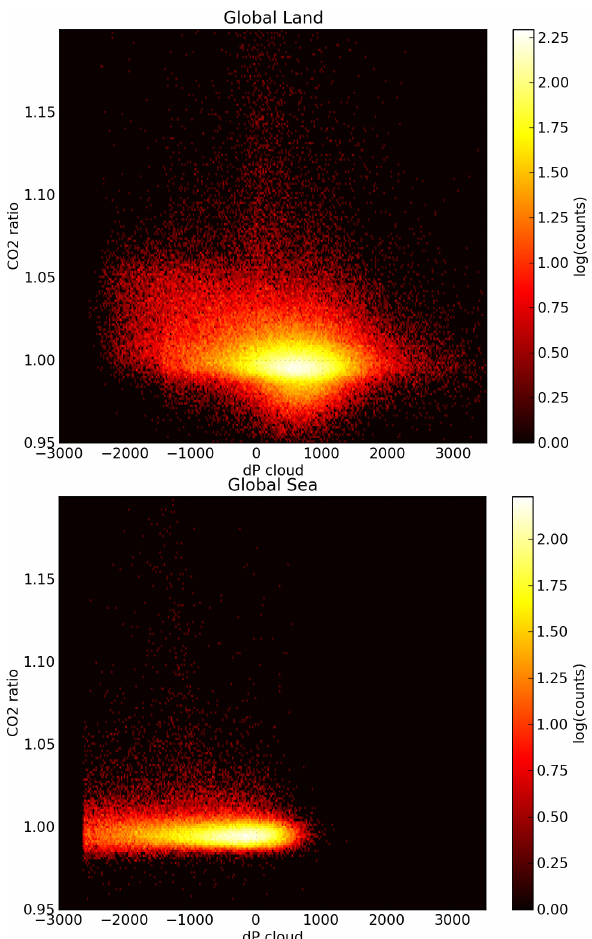
Figure 9. Land/sea sounding distributions for Delta Pressure Cloud (dPc) versus CO2 ratio. 3 Fig. 9. Land/sea sounding distributions for Delta Pressure Cloud (dPc) versus CO 2 ratio.